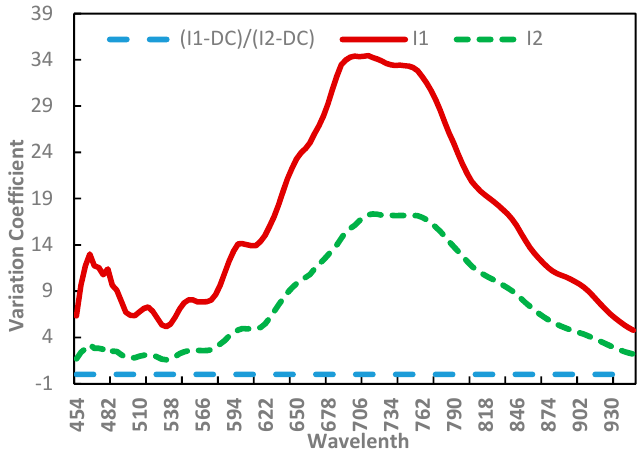
Figure 6. The RRV values in all bands for the uncorrected hyperspectral cube (l1), reference cube (l2) and corrected cube ((l1-DC)/(l2-DC)).